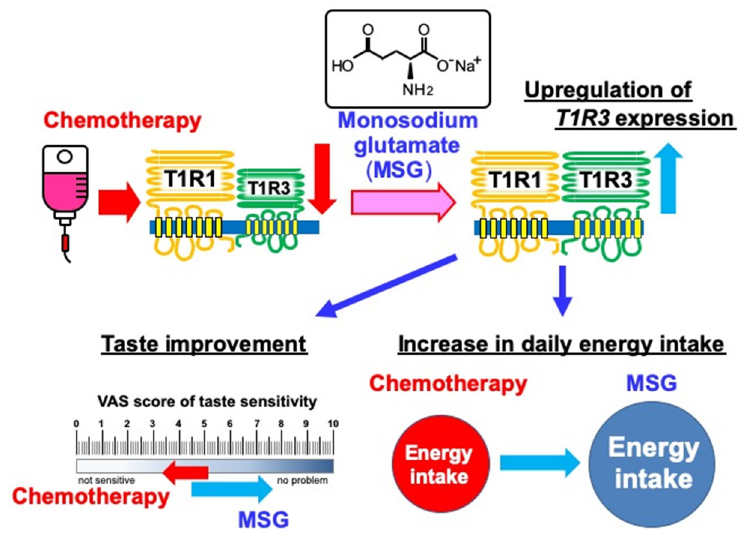
Figure 6. Chemotherapy with MSG supplementation. MSG; monosodium glutamate.